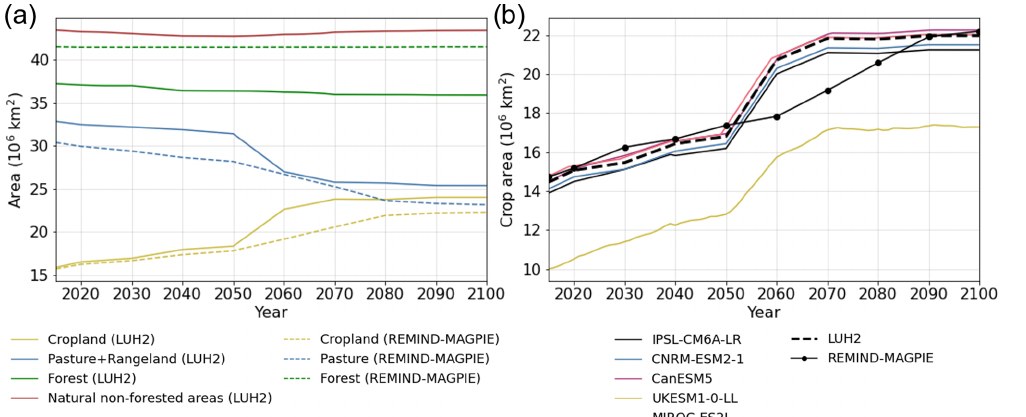
Figure 1. Time series of (a) the changes in the area of croplands, pastures, and forests according to REMIND-MAgPIE and LUH2, and (b) the area of croplands in LUH2, REMIND-MAgPIE, and five CMIP6 ESMs under the SSP5-3.4-OS pathway. In panel (a) , pastures and rangelands of LUH2 are treated together as